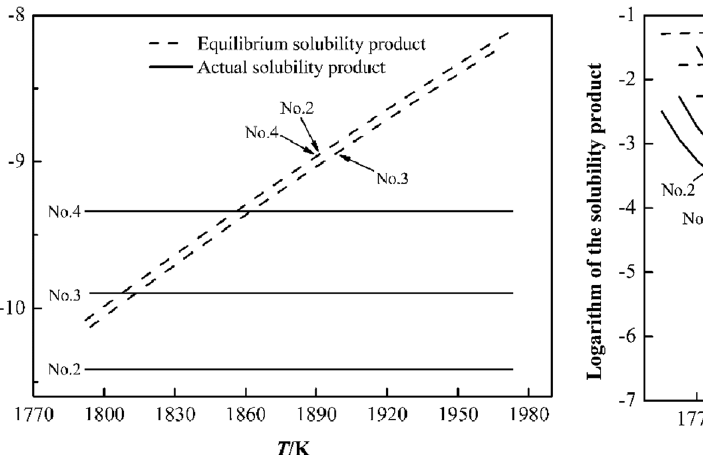
Figure 7: Logarithm of the solubility product as a function of temperature for YS in the liquid steel.